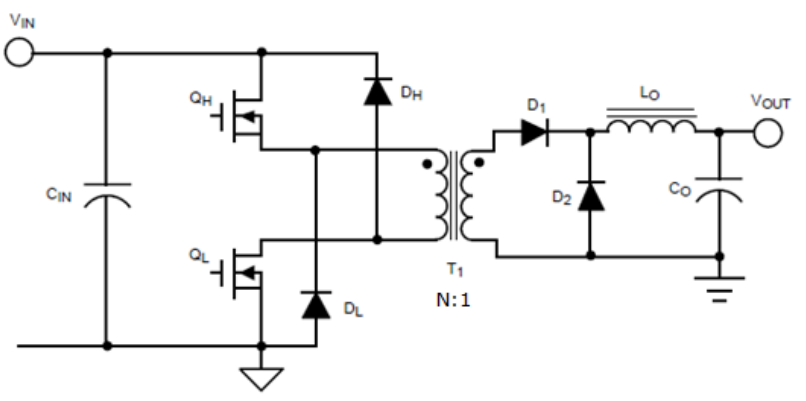
Figure 10. Dual-Switch Forward converter topology.